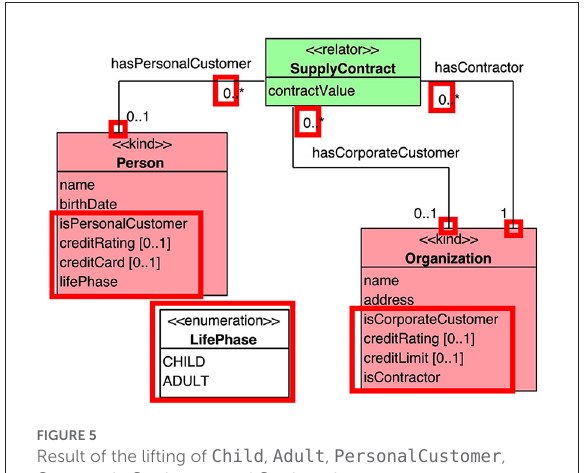
FIGURE5 Result of the lifting of Child , Adult , PersonalCustomer , CorporateCustomer , and Contractor .